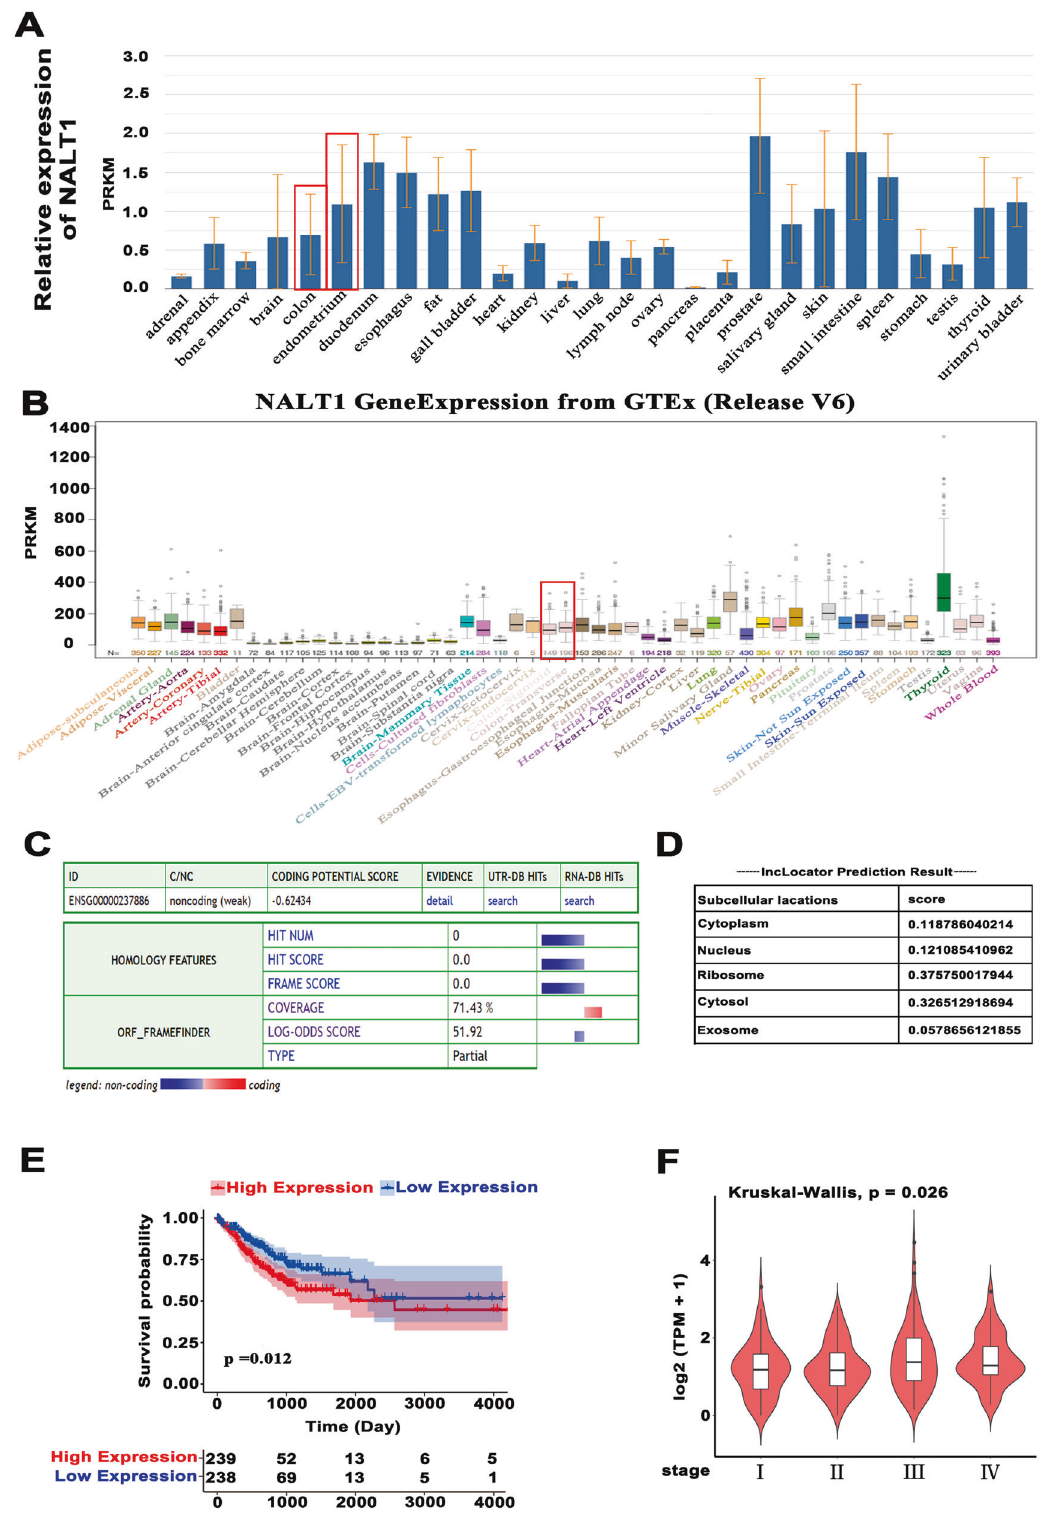
Fig. 1 NALT1 is a noncoding RNA localized in nucleus and cytoplasm that might be an oncogene in CRC. A , B Expression of NALT1 in normal tissues derived from UCSC and NCBI. C CPC assessed that NALT1 has lost its protein-coding capability. D lncLocator was applied to estimate the subcellular localization of NALT1. E Patients with high NALT1 expression survived shorter than those with low NALT1 expression. F NALT1 expression was increased during the high-risk stage.